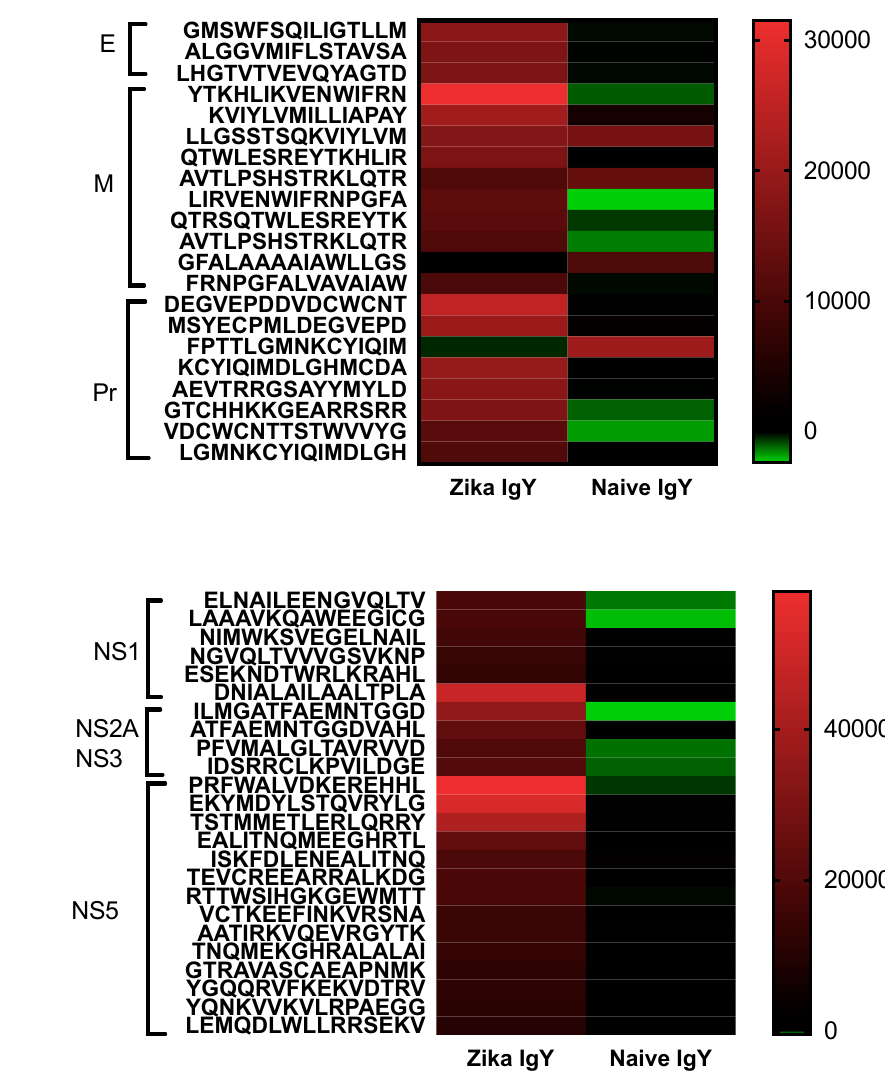
Figure 5. An epitope map of the structural and nonstructural genes: ( A ) A heat map of the structural epitopes of the Zika virus recognized by Zika-specific IgY and naïve IgY and ( B ) a heat map of the non-structural epitopes of the Zika virus recognized by Zika-specific IgY and naïve IgY. The strength of binding is indicated on a colorimetric scale with red being a strong binding affinity and green being no binding.